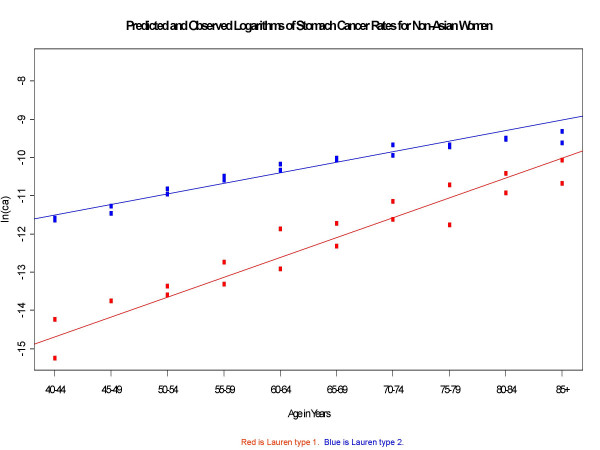
Plot of the natural logarithms of cancer rates, denoted as ln(ca), as a function of age in years for non-Asian women. Red references Lauren type 1 gastric cancer. Blue references Lauren type 2 gastric cancer. Lines represent predicted values. [see Additional file 1]